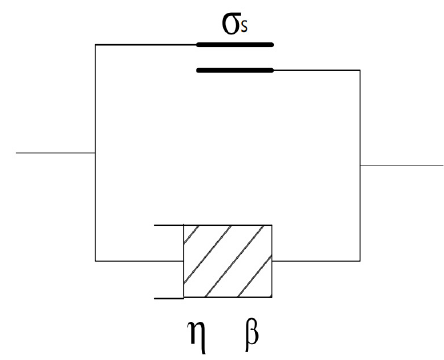
Figure 10. Viscoplastic body.